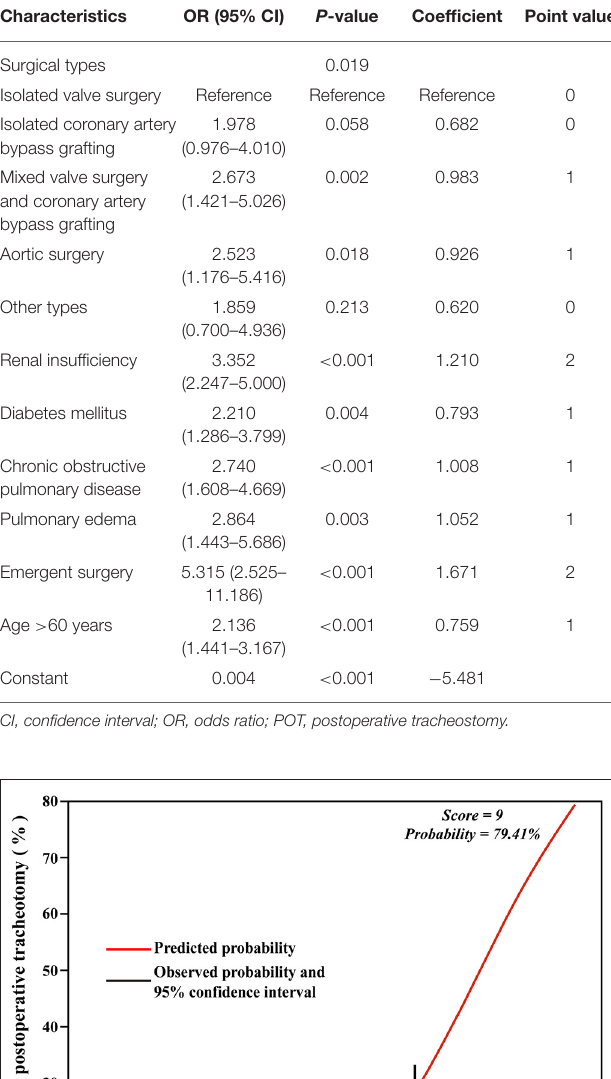
Table 4 ). Similarly, higher frequency of readmission to ICU, longer ICU, and hospital stay were observed in patients with